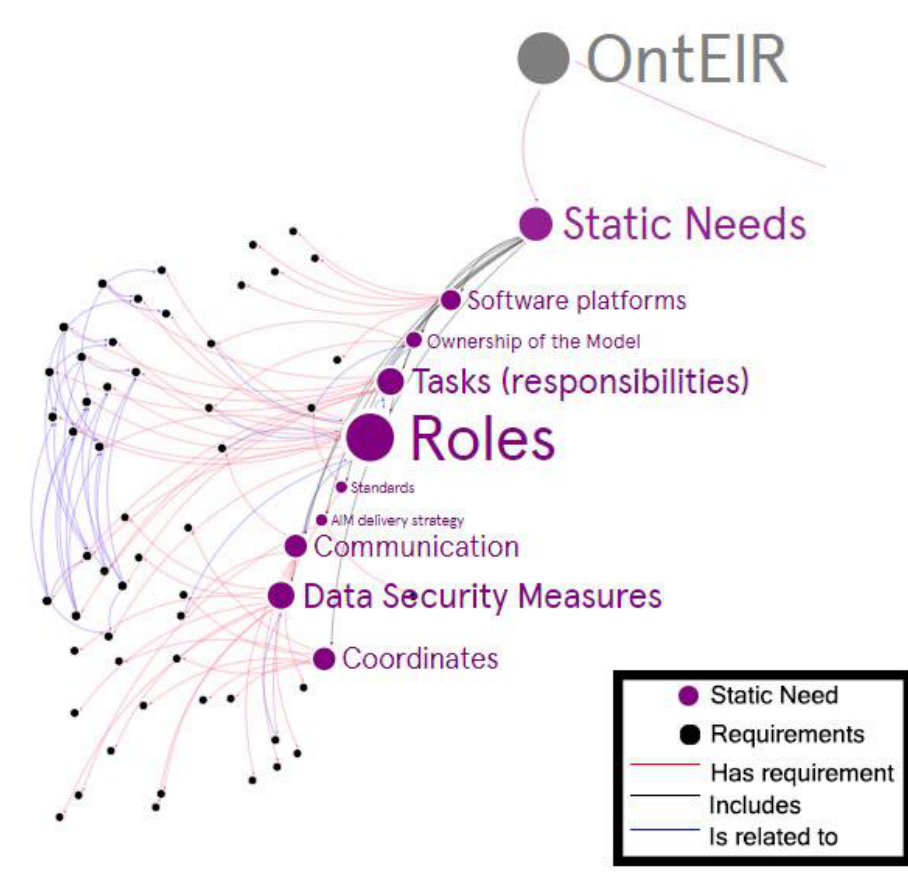
Figure 4. Static